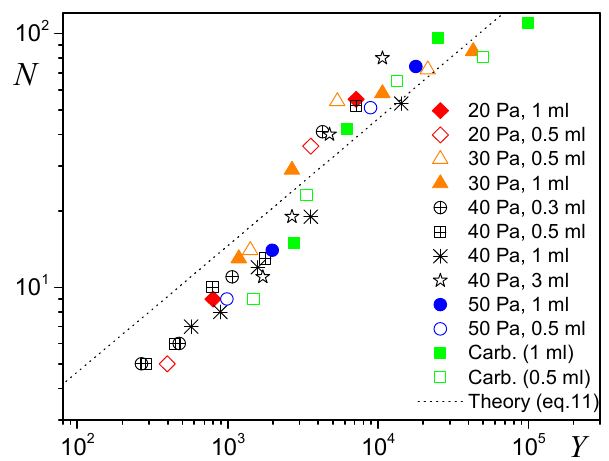
Figure 6. Saffman instability during traction tests with emulsions of various yield stresses, for various sample volumes and various initial thicknesses: Number of fingers as a function of the parameter Y .